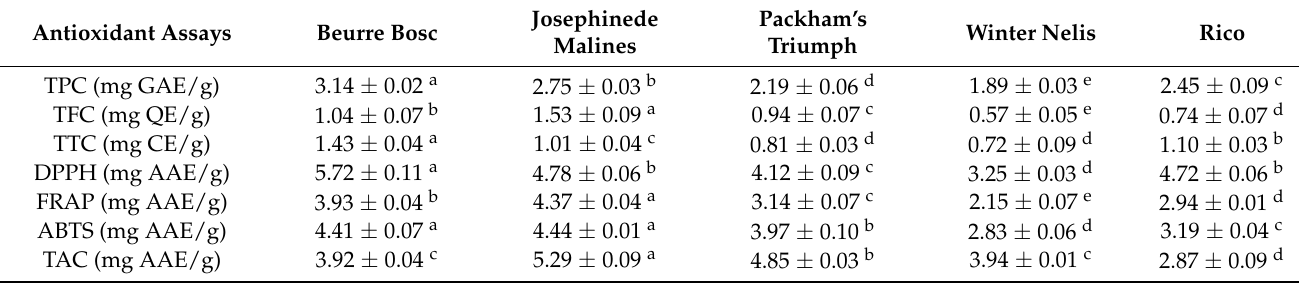
Table 1. Antioxidant potentials of five Australian grown pear varieties. Antioxidant